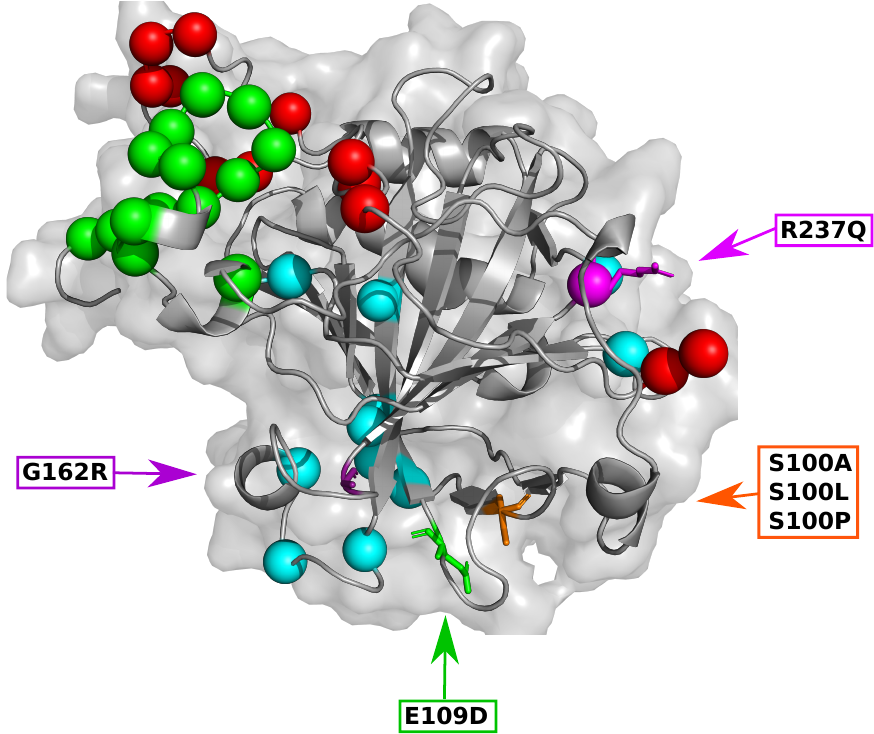
Figure 1. 3-dimensional image of carbonic anhydrase VIII (CA-VIII) showing the SNV location, predicted binding site residues and location of each motif. Orange : S100A, S100L and S100P; Green : E109D; Purple : G162R; Magenta : R237Q. Spheres represent the binding site residues identified by SiteMap and CPORT, Green: Gly26, Val27, Glu28, Trp29, Gly30, Tyr31, Glu32, Glu33, Gly34, Val35, Glu36, Leu39, Val40, Ala44; Blue: Leu93, Lys94, Glu111, Tyr113, Arg116, Ser147, Gly151, Ile153, Asp214, Ile224, Arg237, Tyr238; Red: Thr255, His256, Leu262, Val263, Glu264, Gly265, Ile269, Phe274, Pro276, Gln278, Phe289,